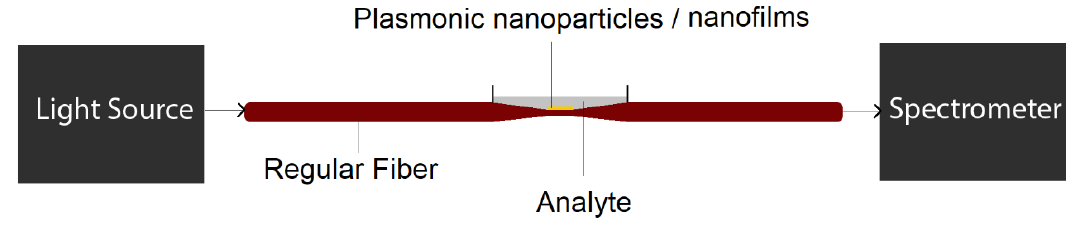
Figure 8. The schematic of a potential plasmonic biosensing setup based on tapered optical fibers. Lin et al. [32] proposed a tapered SPR-based fiber-optic biosensor for monitoring anti-DNP (N- (2, 4-dinitrophenyl)-6-aminohexanoic acid) antibody. The Au nanoparticles were used as plasmonic